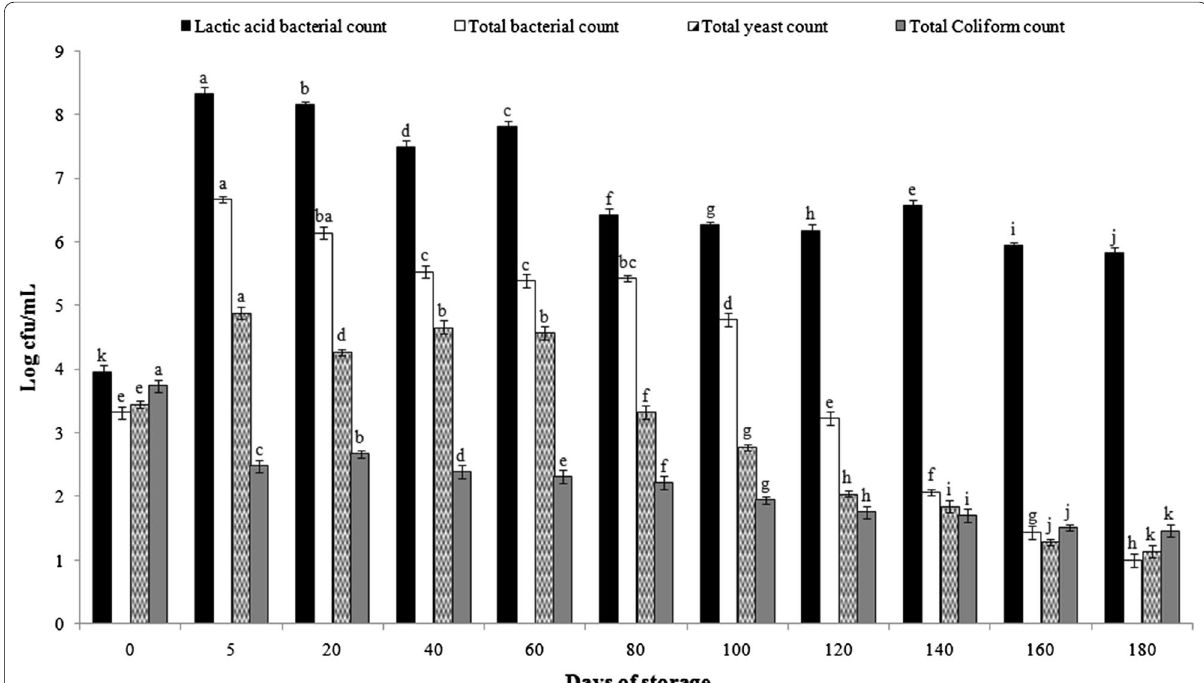
Fig. 1 Changes in lactic acid bacterial and total bacterial count during 6 months in Kanji beverage. *All observations are average of triplicates. **Means with the same letter are not significantly